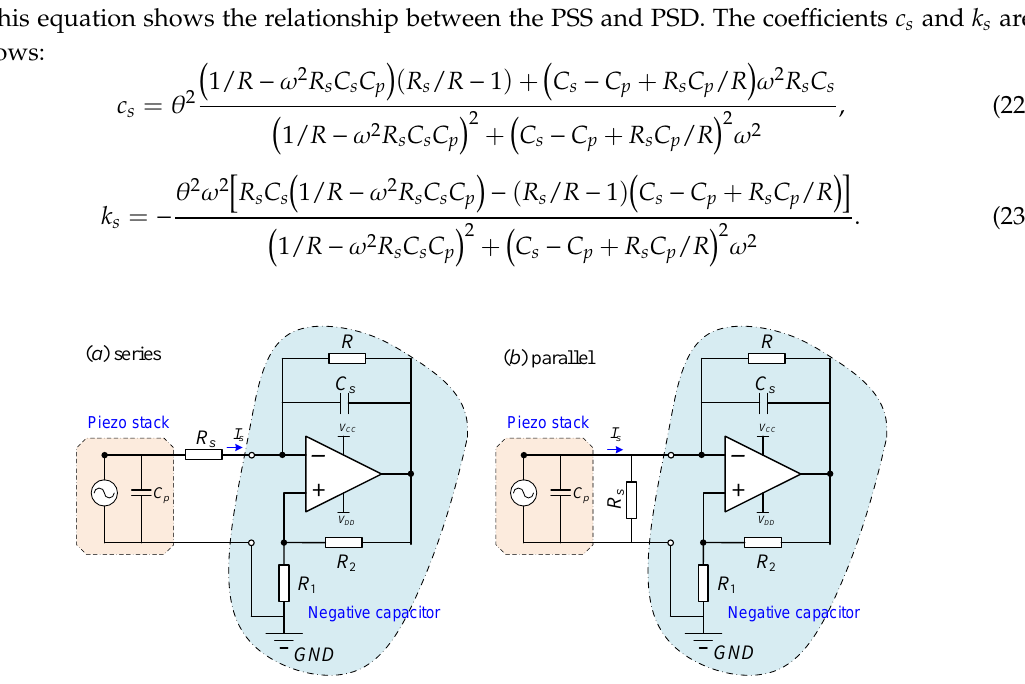
Figure 4. Piezoelectric stack transducer with negative capacitance and adjustable resistance R s : ( a ) in series and ( b ) in parallel. The resistor R is utilized to increase the leakage of the capacitor C s .